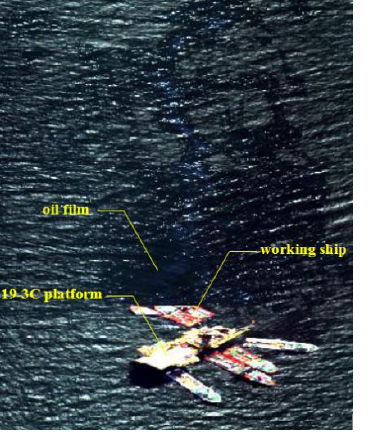
Figure 1. AISA+ hyperspectral image （ R 107 ， G 68 ， B 28 ）